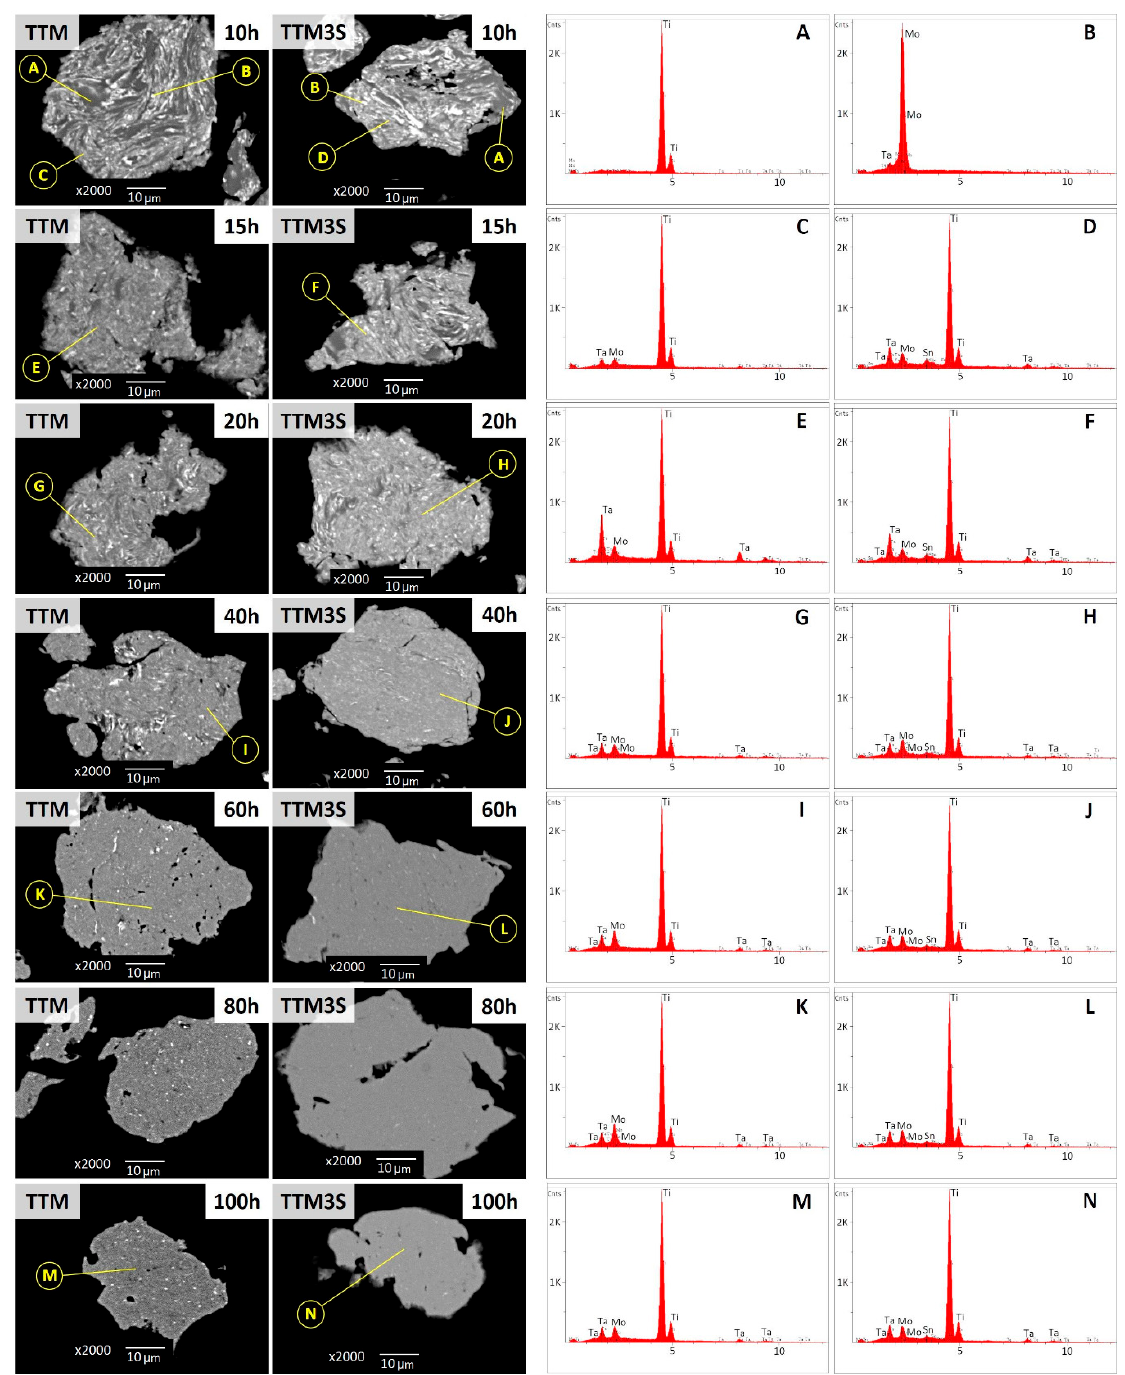
Figure 5. SEM ‐ Backscattered electrons images and SEM ‐ EDS point analysis of TTM and TTM3S Figure 5. SEM-Backscattered electrons images and SEM-EDS point analysis of TTM and TTM3S powders after 10, 15, 20, 40, 60, 80 and 100 h of milling. powders after 10, 15, 20, 40, 60, 80 and 100 h of